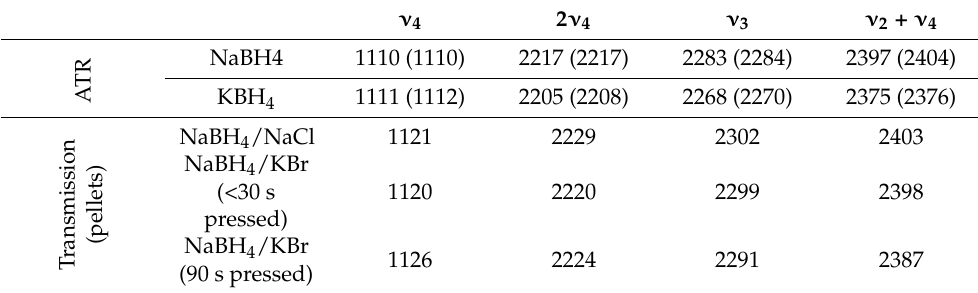
Table 2. ATR frequencies of NaBH 4 and KBH 4 compared to ATR values of Renaudin et al. [32] (values in brackets) in addition to the transmission IR frequencies of NaBH 4 in KBr and NaCl